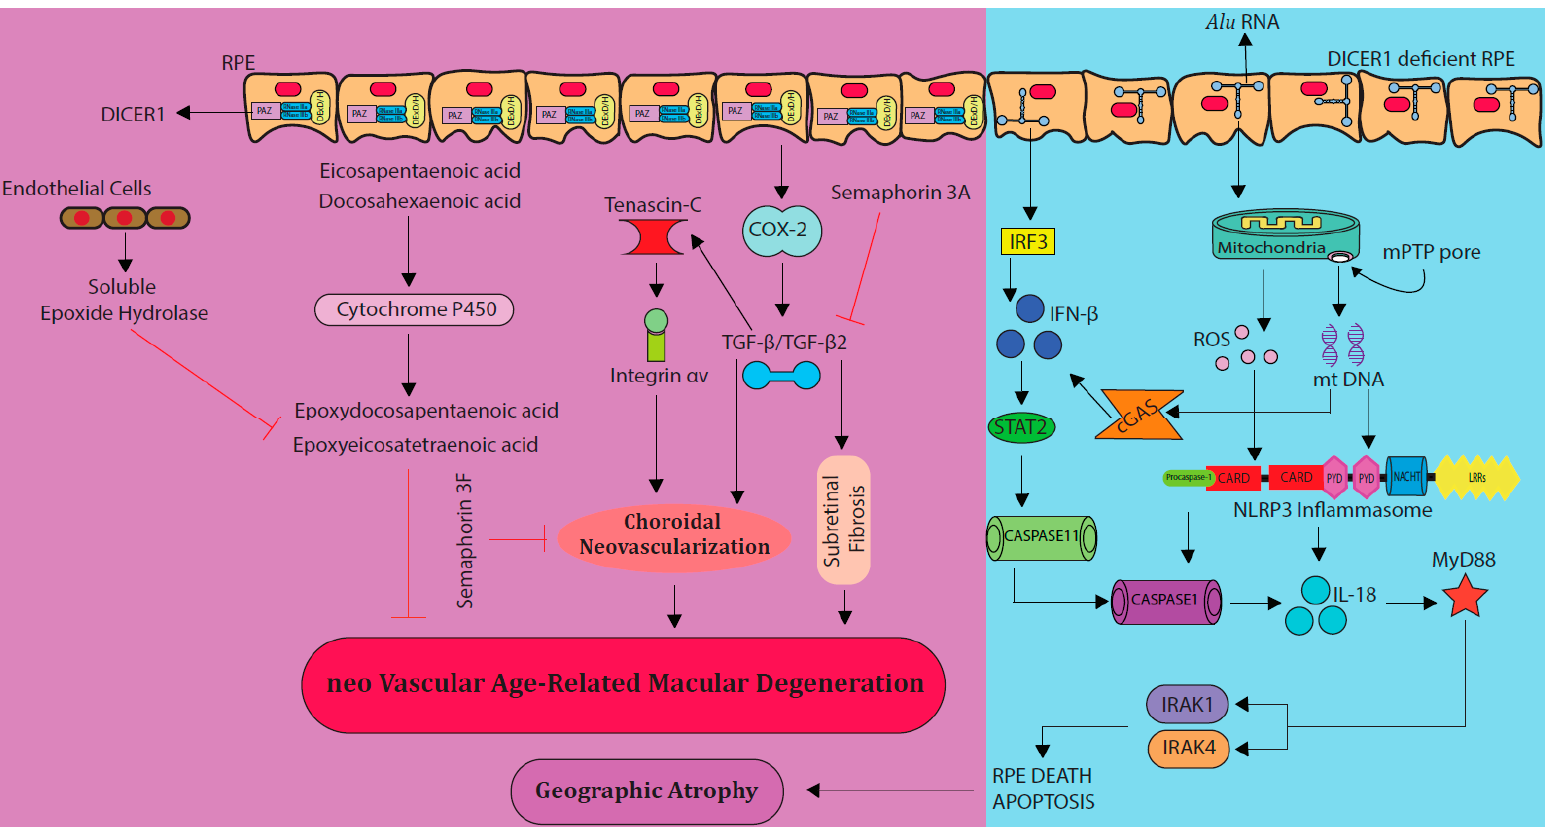
Figure 1. Major signaling pathways involved in the development of nAMD other than vascular endothelial growth factor (VEGF) (purple panel on the left-hand side). Cytochrome P450, cyclooxygenase-2 (COX-2), and Transforming growth factor- β (TGF- β ) pathways play critical role in CNV leading to nAMD. On the other hand, semaphorins (3A, 3F) and cytochrome P450 metabolites naturally inhibit the formation of choroidal neovascularization (CNV). DICER 1 enzyme plays a crucial role in Alu RNA breakdown, preventing GA. In DICER 1-deficient RPE (blue panel on the right-hand side), Alu RNA deposits in retinal pigment epithelium (RPE), activating the NLRP3 inflammasome, and cyclic GMP-AMP synthase (cGAS) activates the noncanonical inflammasome, ultimately leading to apoptosis of RPE, and geographic atrophy (GA) development. ROS—reactive oxygen species.